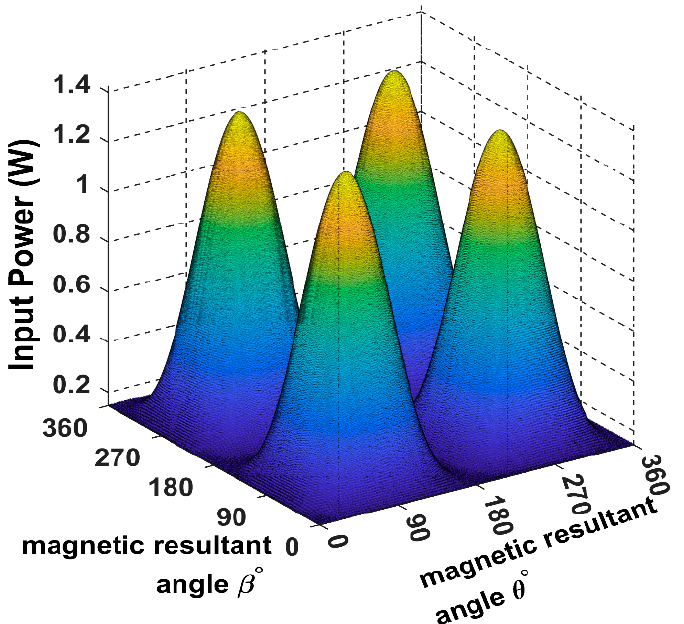
Figure 12. The input power plot for the 3D WPT system when the receiver is placed at α = φ = 90°.